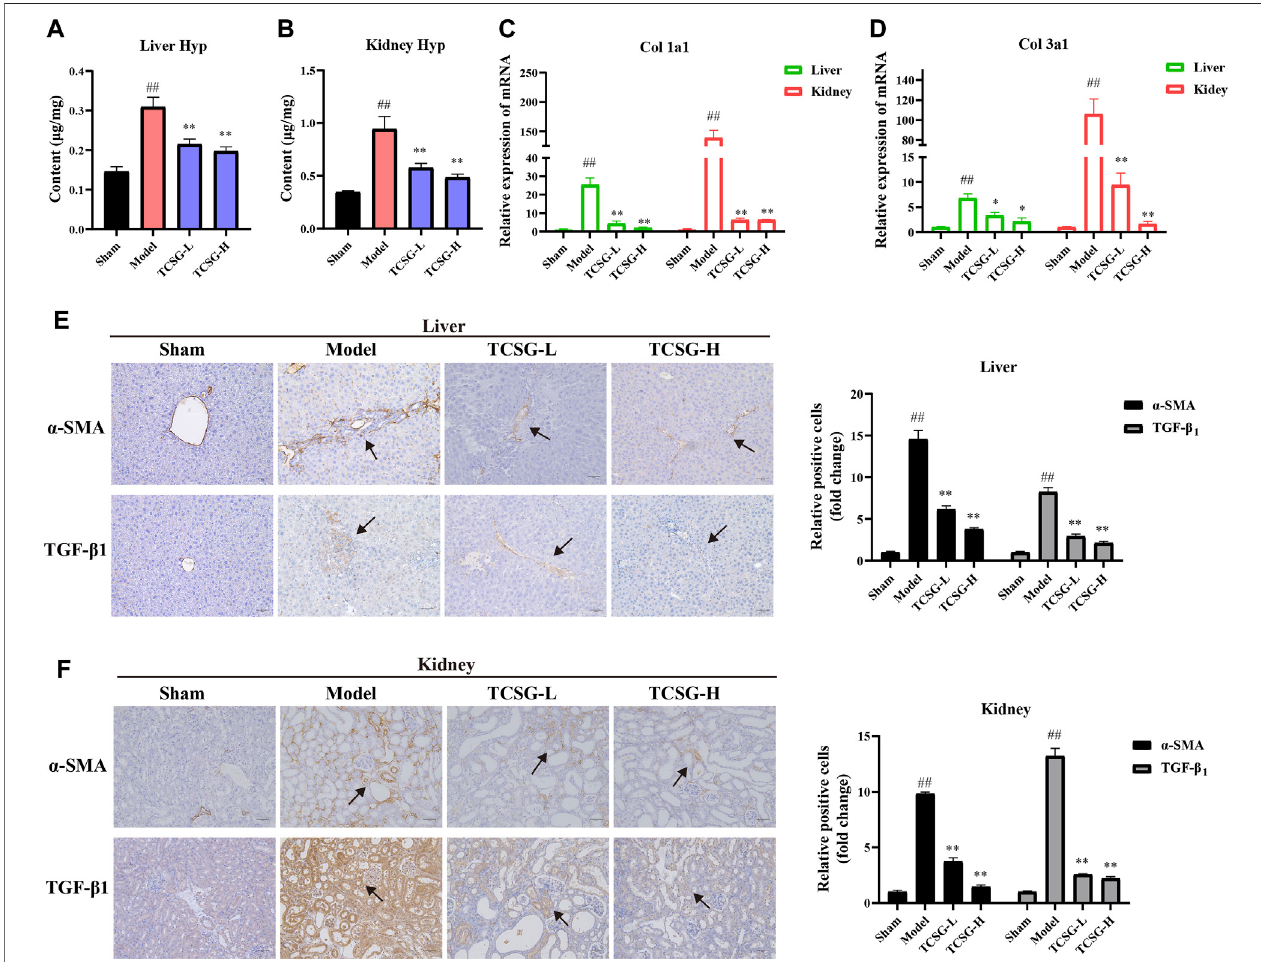
FIGURE3| TCSGfrom Baishouwu inhibitedhepaticandrenal fi brosisinBDL&UUOmice. (A) Liverhydroxyprolineconcentrationassays. (B) Kidneyhydroxyproline concentration assays. (C,D) mRNA expressions of Col 1a1 and Col 3a1 in mice liver and kidney samples. (E) Immunohistochemistry and quantitative analysis of the levelsof α -SMAandTGF- β 1intheliver. (F) Immunohistochemistryandquantitativeanalysisofthelevelsof α -SMAandTGF- β 1inthekidney.Dataareshownasmeans ± SEM ( n (cid:1) 6), ## p < 0.01, signi fi cantly different from sham group; * p < 0.05, ** p < 0.01, signi fi cantly different from model